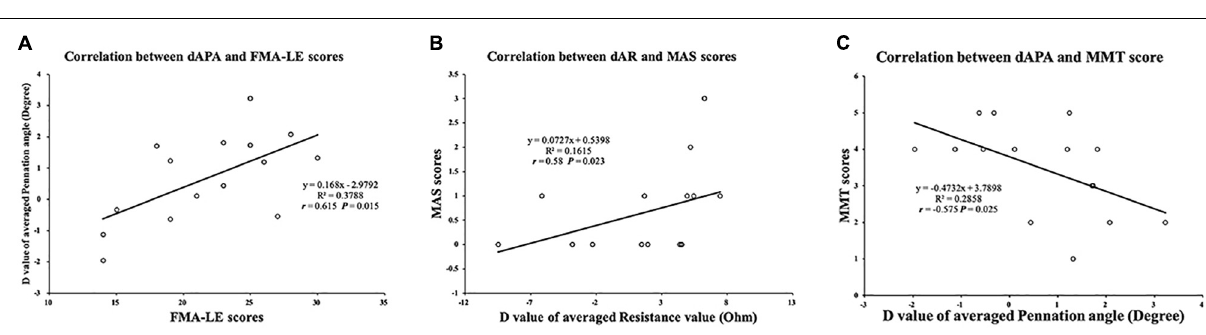
component properties (Li X. et al., 2017; Zong et al.,